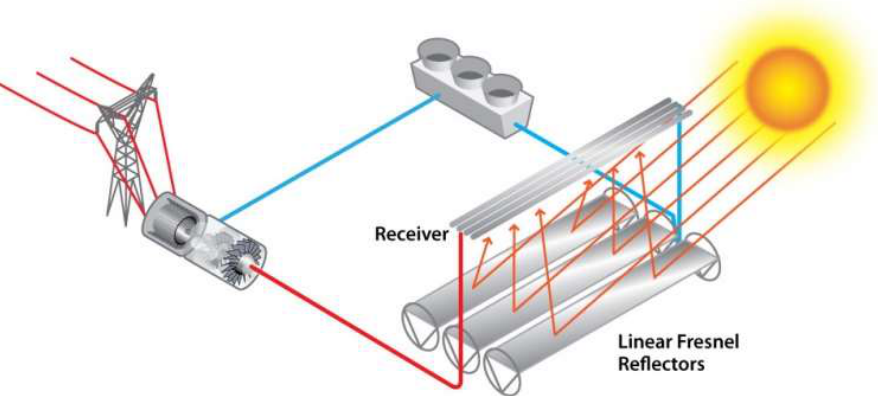
Figure 3. Linear Fresnel reflector power station. Source: Office of Energy Efficiency and Renewable Energy [27]. (i) Flat mirrors are used to redirect sunlight onto a collection surface. (ii) Pipes along the collection surface are filled with heat transfer fluid. (iii) Heated fluid is used to drive steam turbine generators. (iv) Fluid can be stored to generate power when the sun is not visible.